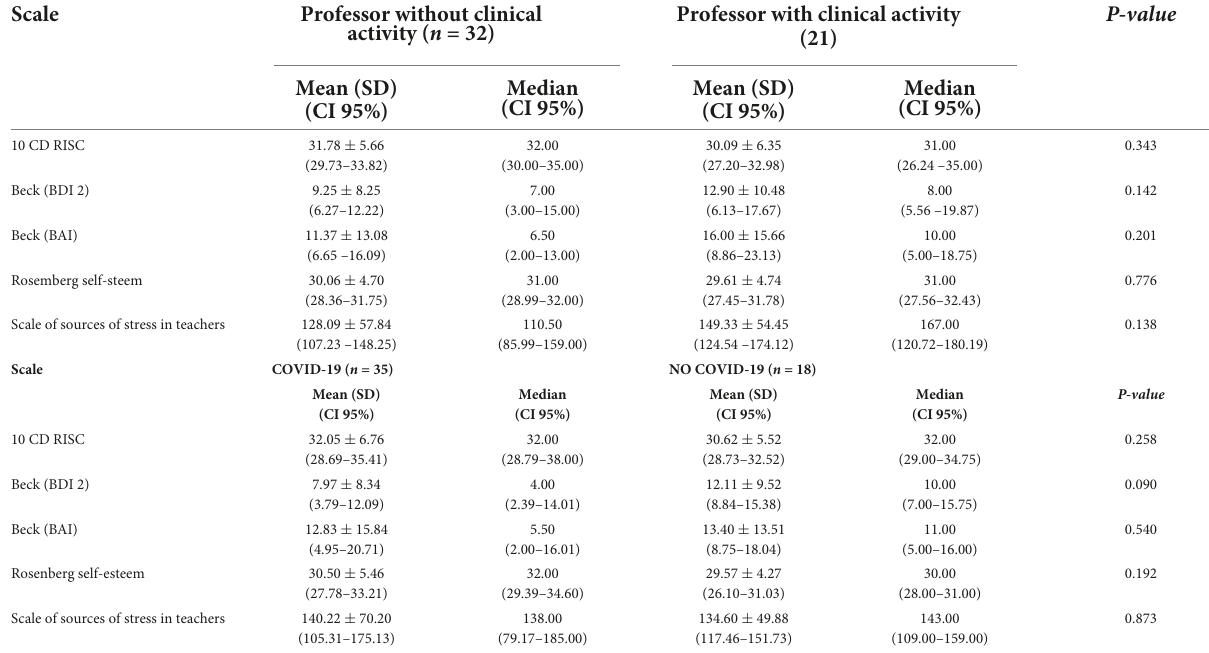
TABLE 5 Differences between professors with and without clinical activity and differences in those with/without coronavirus 2019 (COVID-19). P-value Scale Professor without clinical Professor with clinical activity activity ( n = 32) (21)